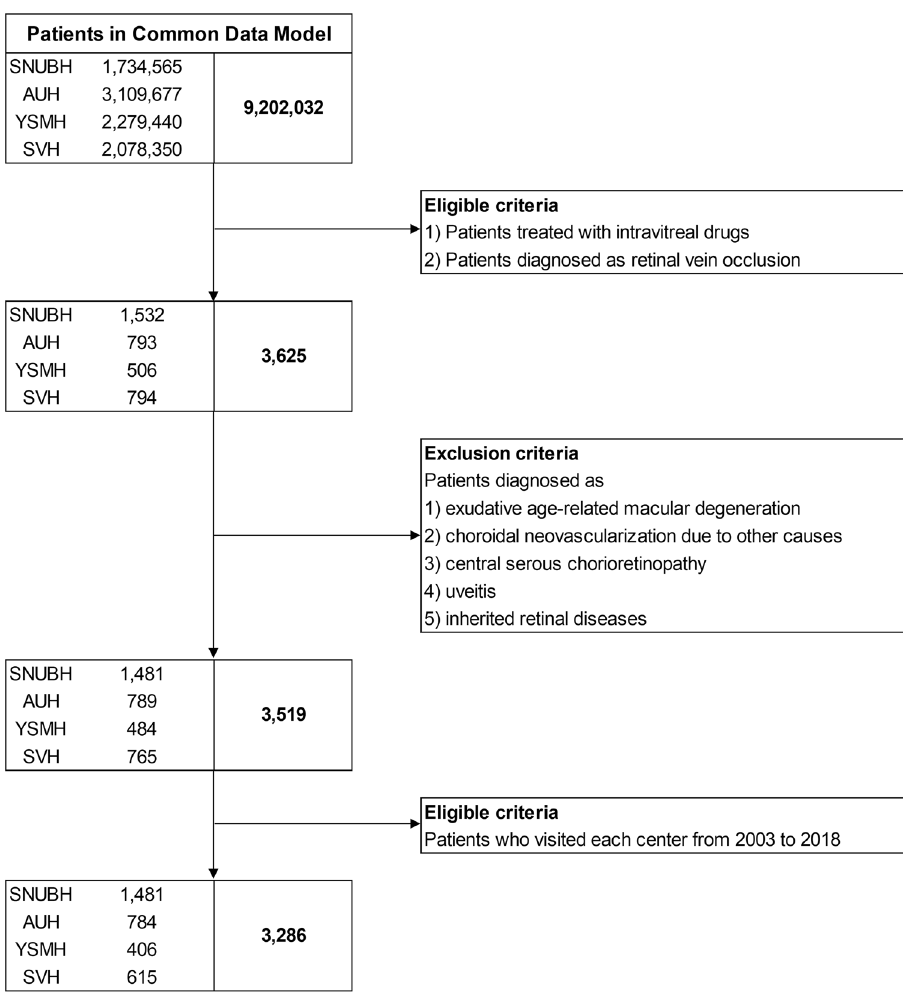
Figure 2. Patient selection flowchart. SNUBH, Seoul National University Bundang Hospital; AUH, Ajou University Hospital; YSMH, Yeoeuido Saint Mary’s Hospital; SVH, Saint Vincent’s